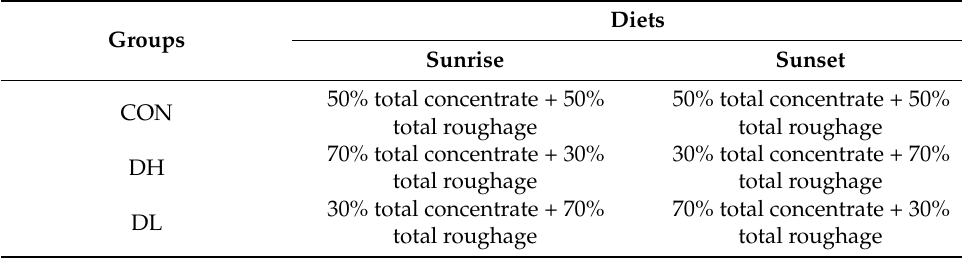
Table 2. Experimental design of circadian rhythm (Feeding mode).